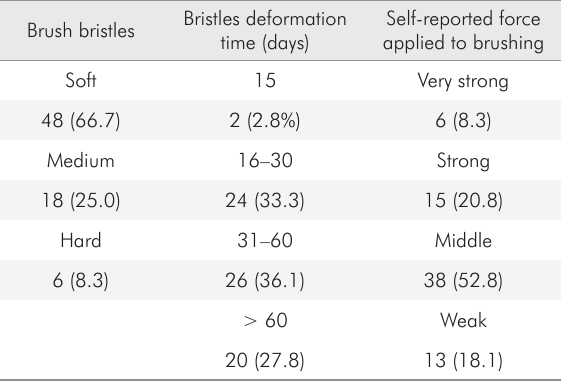
Table 1. Toothbrushing habits of the